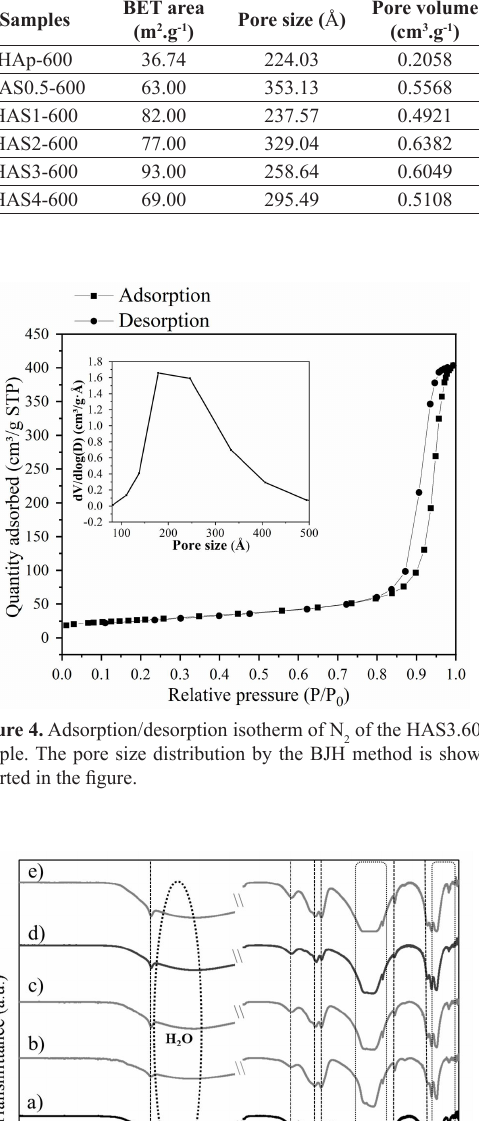
Table 2. Textural parameters of the synthesized samples. Samples